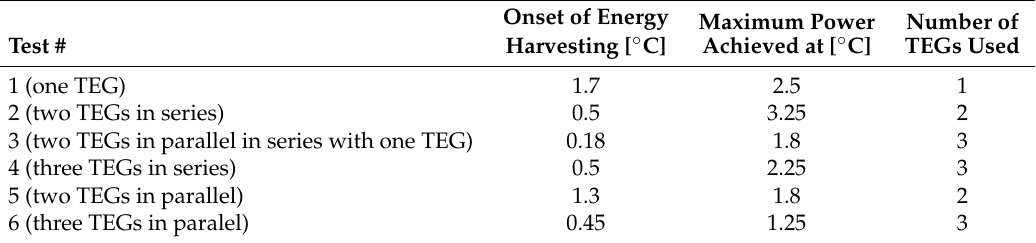
Table 2. Compilation of test